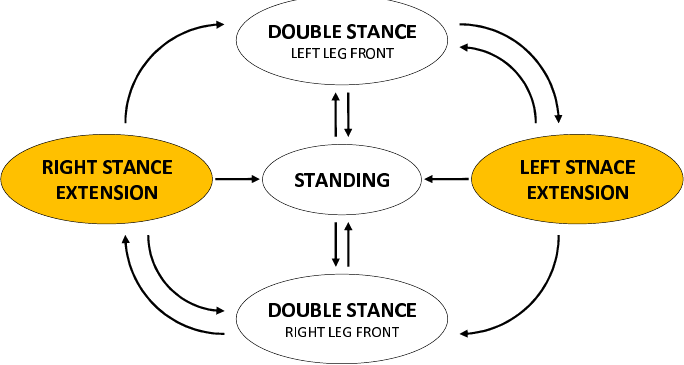
Figure 2. Finite-state machine for a reciprocating gait orthosis with hip actuation.